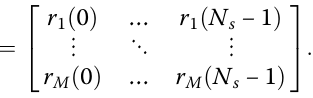
ffiffiffiffiffiffiffiffi p a = b and U = a 2 /(4 b ). The two minimum points P 0